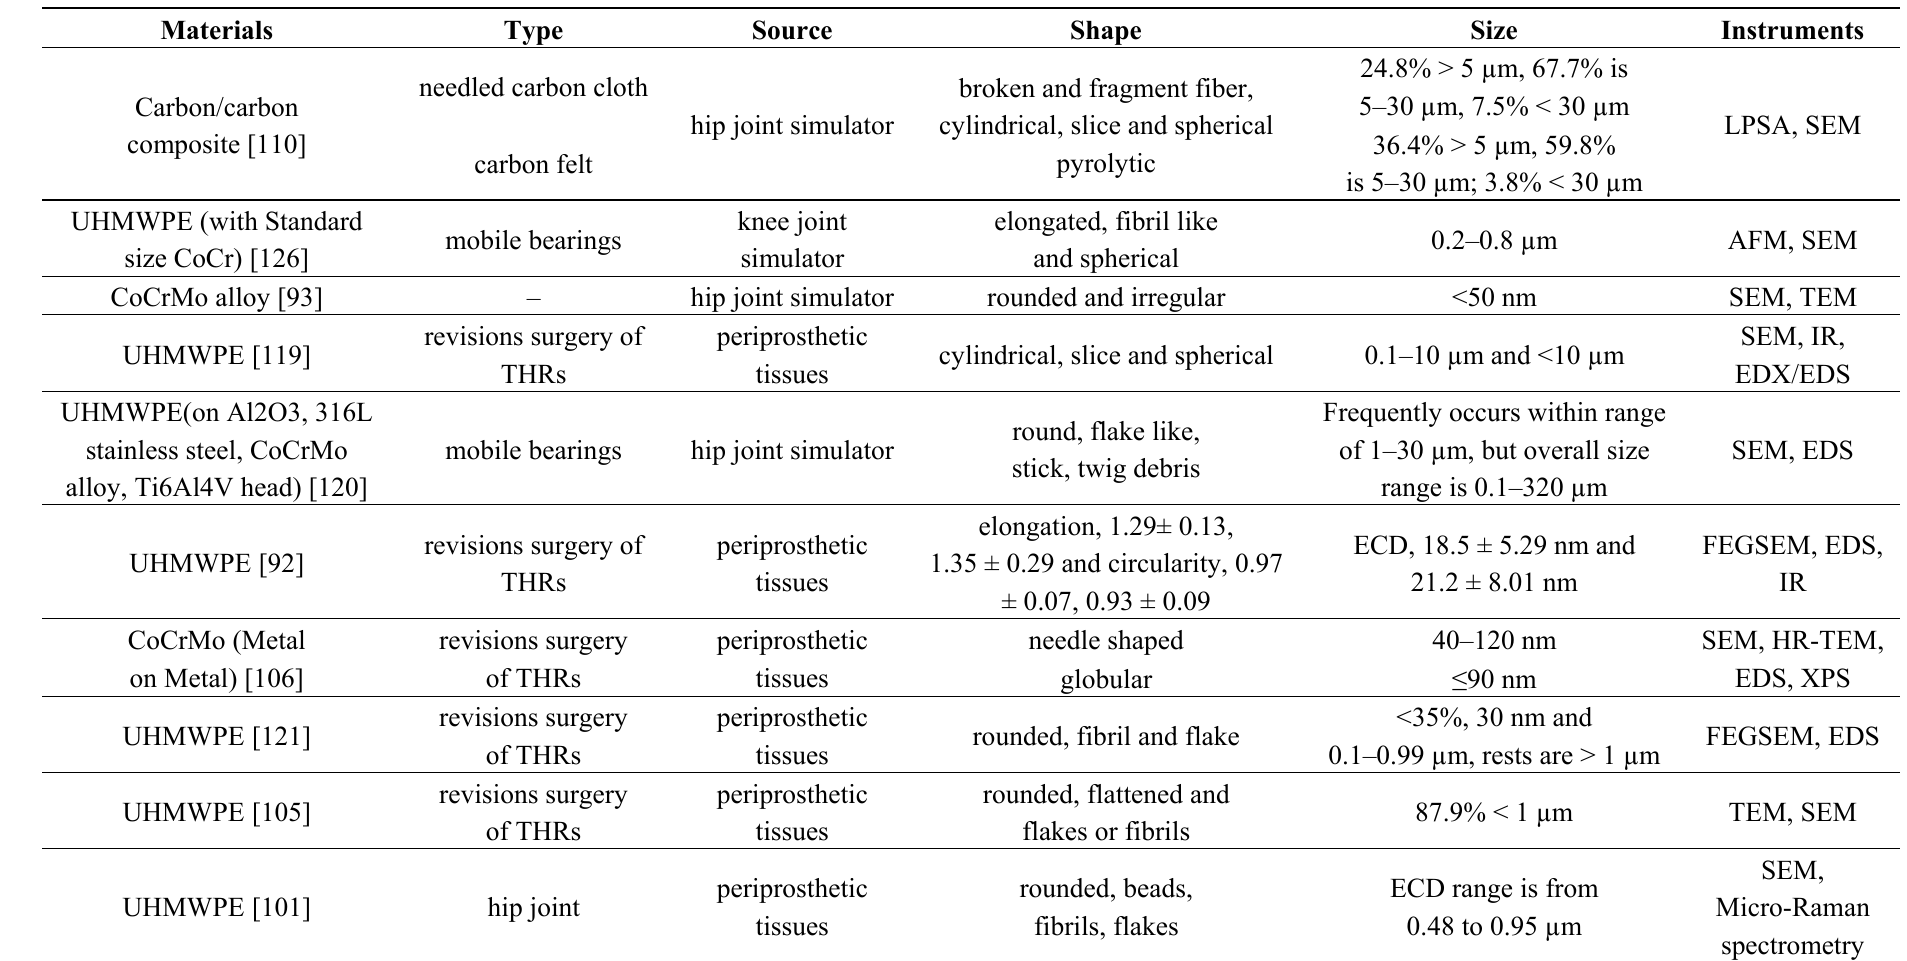
Table 3. Characterization of wear debris of different